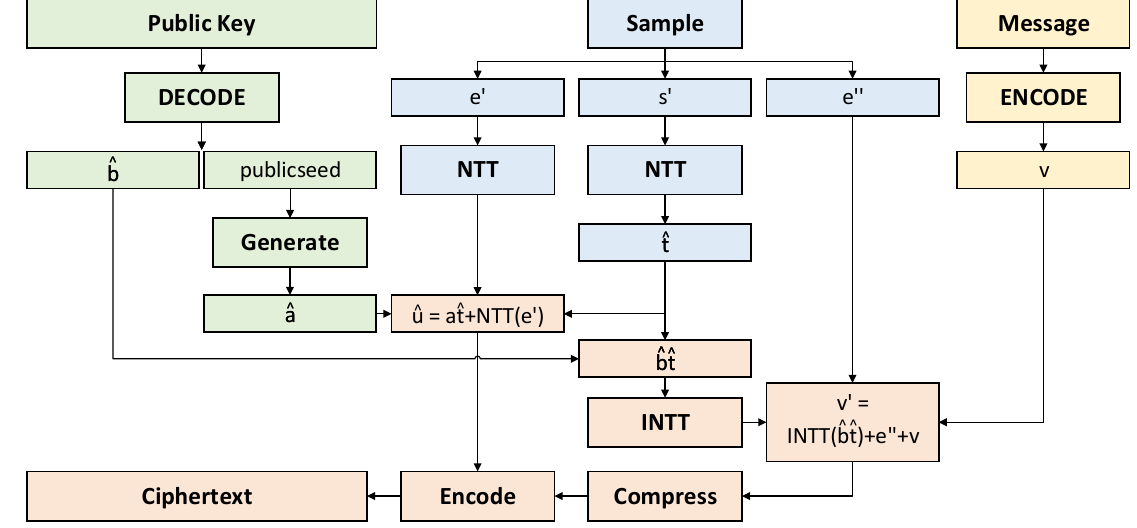
Figure 2. NewHope encryption